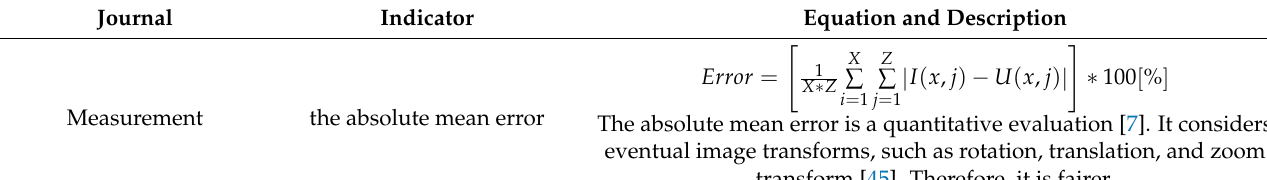
Table 2. Different performance indicators used for evaluating the reconstruction quality. Indicator Equation and Description